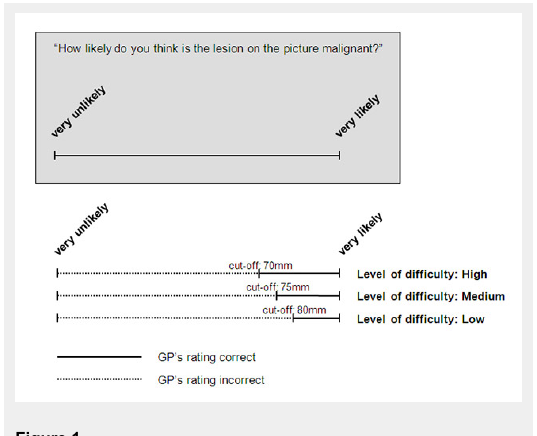
Figure 1 Example of the interpretation (picture with a malignant lesion).